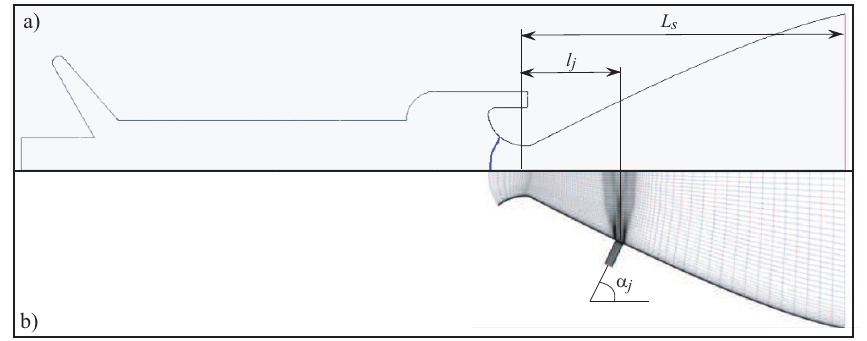
Figure 3. Full geometric model ( a ) and geometrical model used in calculations ( b